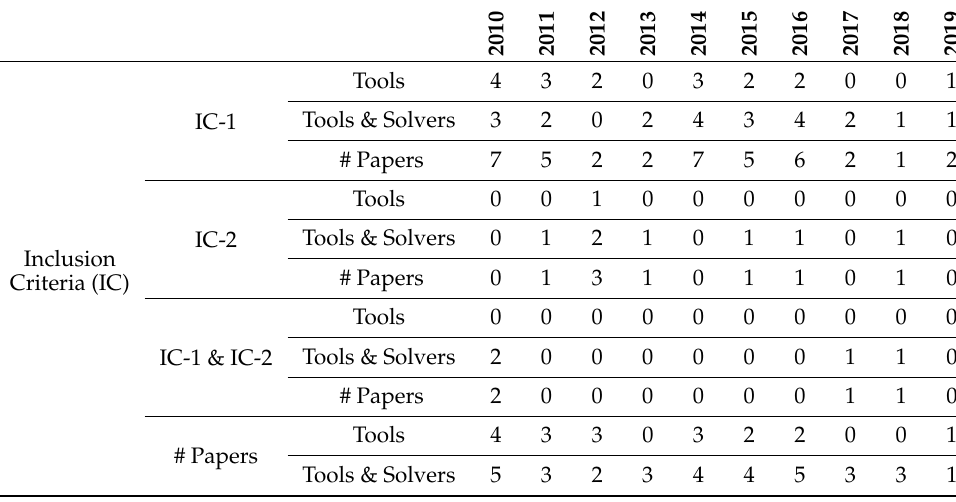
Table 5. Filtered articles classified by year and way for reaching their main goal.